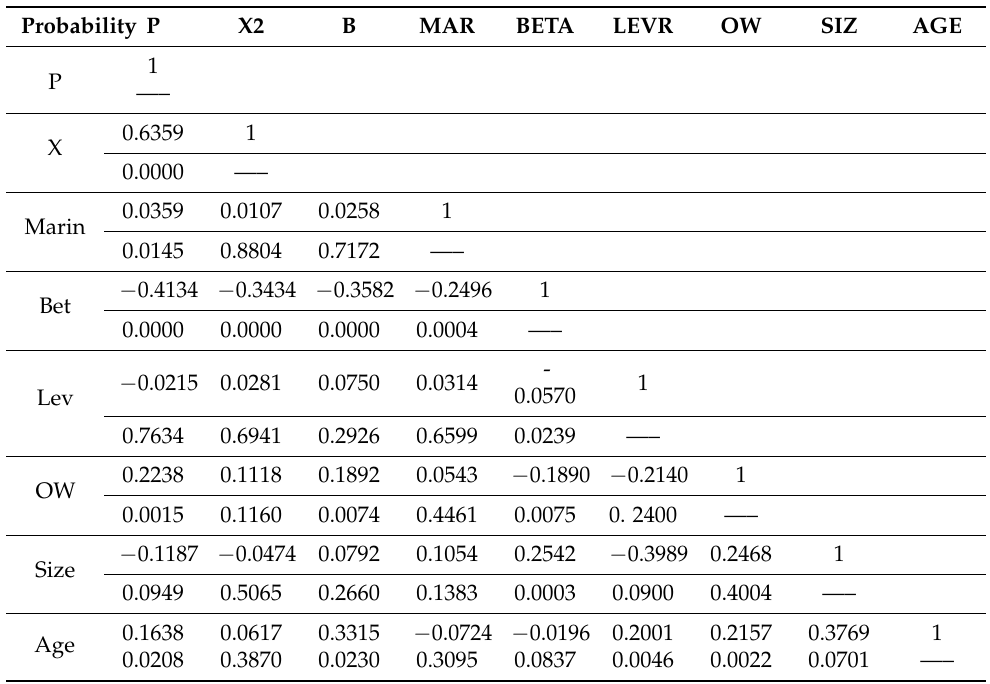
Table 4. Variable correlation matrix.